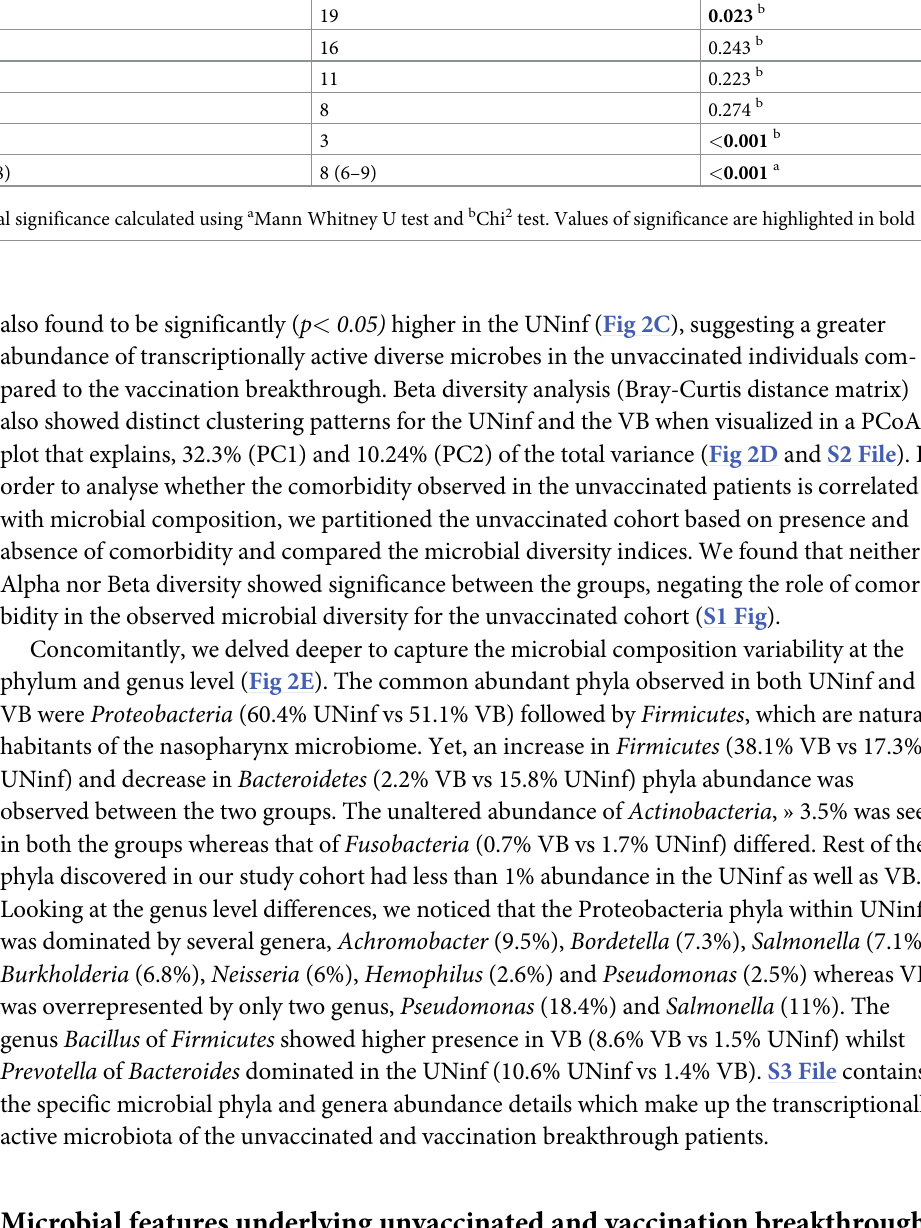
Data are shown as median (IQR) or n (%). Statistical significance calculated using a Mann Whitney U test and b Chi 2 test. Values of significance are highlighted in